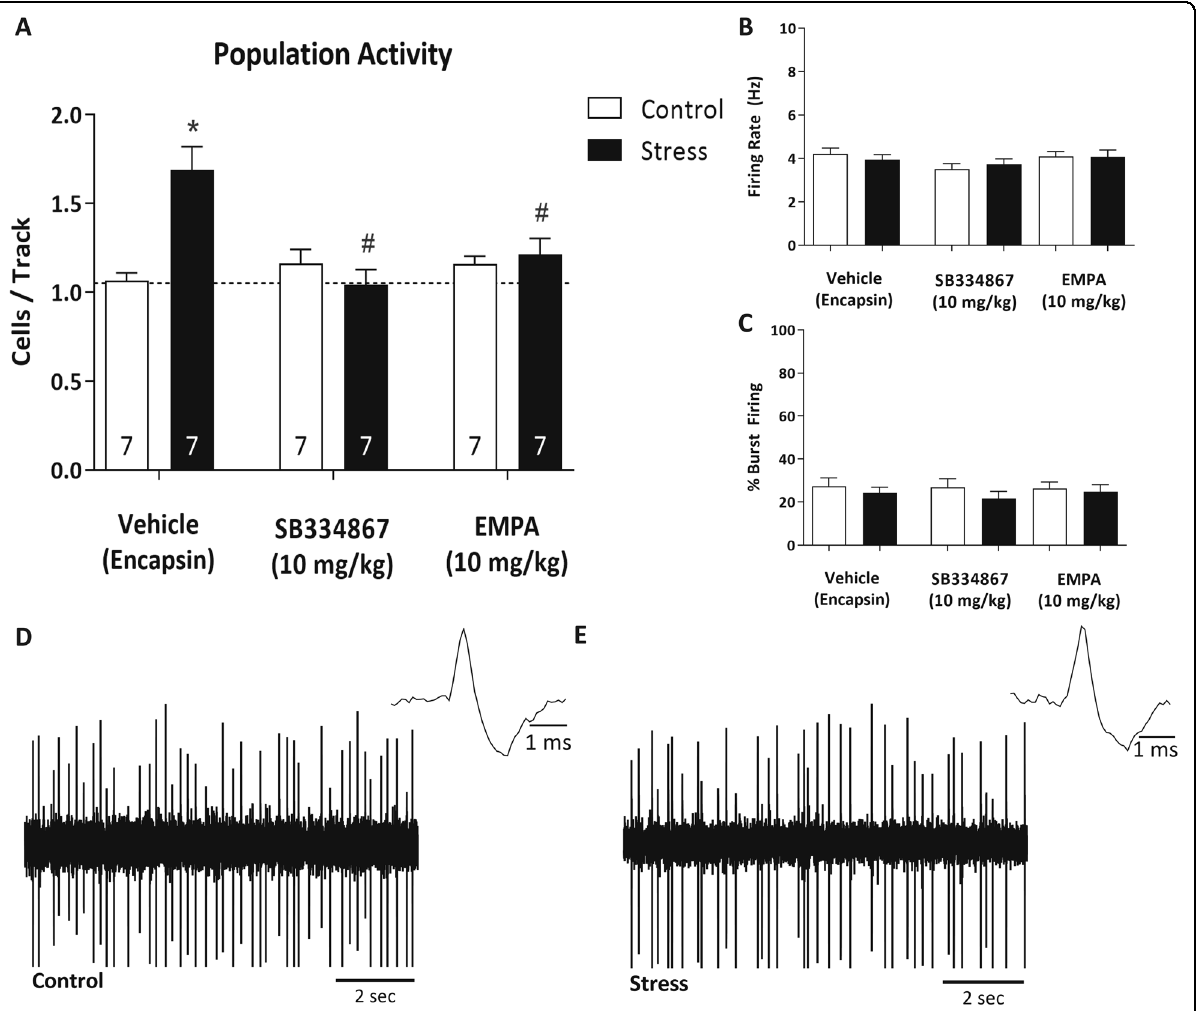
Fig. 3 Selective OX 1 R and OX 2 R antagonists reverse stress-induced aberrant VTA dopamine neuron activity. In vivo extracellular electrophysiology was used to record dopamine cell activity in the VTA, following stress. a Two-day inescapable foot-shock resulted in a signi fi cant increase in the number of spontaneously active dopamine neurons per electrode track. This increase was reversed by both SB334867 and EMPA. *p < 0.05 compared with control/vehicle; #p < 0.05 compared with stress/vehicle. There were no signi fi cant differences in b fi ring rate or c bursting pattern of recorded dopamine cells. Representative traces from control animals ( d ) and two-day inescapable shock animals ( e ). n = 7 rats per